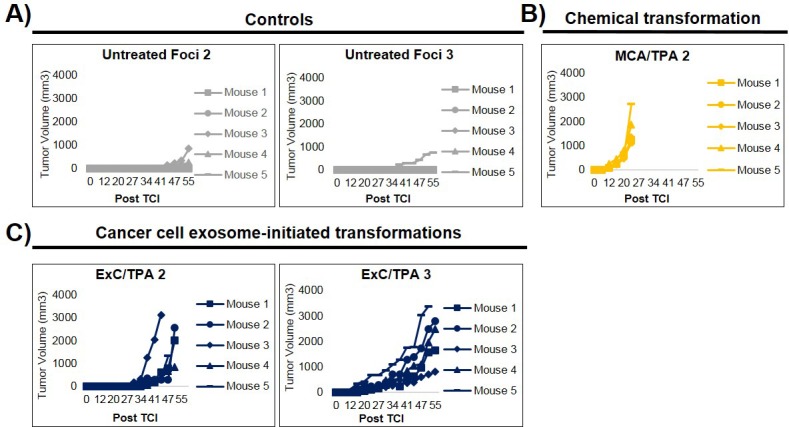
Additional in vivo studies of transformed cells.(A) Results from additional foci tested from injection of background foci formed from untreated NIH/3T3 cells. Transformed cells were injected at a concentration of 1 × 106 cells. Results showed tumor growth in six out of 15 total mice (five tumors grew from ‘Untreated Foci 2’). (B) Additional independent focus tested from MCA/TPA transformed cells (n = 5). (C) Additional foci tested from Capan-2 exosome (ExC)/TPA transformed cells (n = 5).